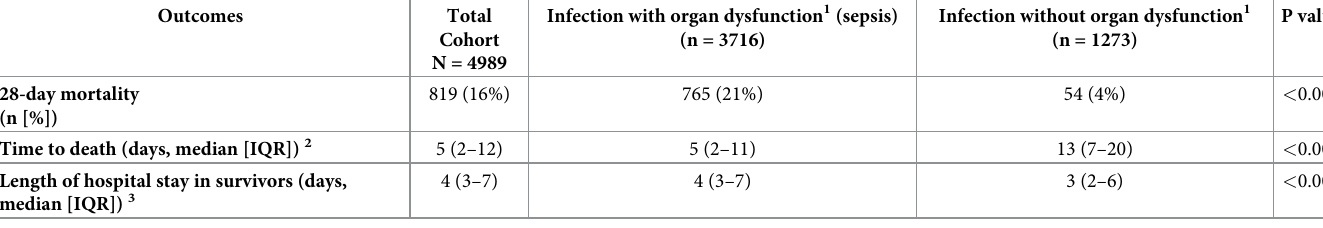
Table 3. Outcomes of infected patients with and without organ dysfunction within 24 hours of